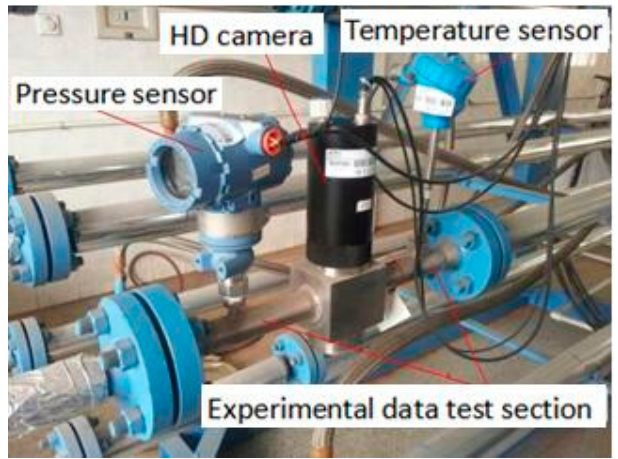
Figure 2. Picture of the sensors equipped.